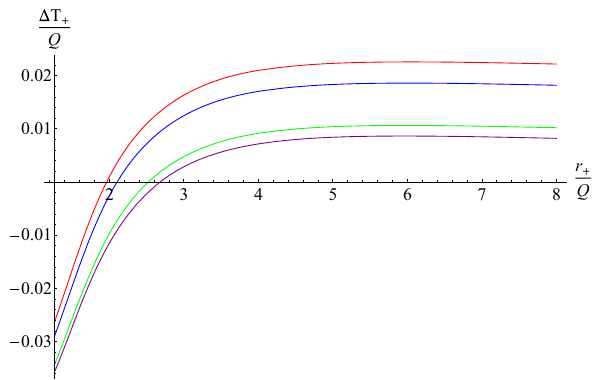
Fig. 6 We plot the difference of the temperature of the non-linear and usual charged dS black holes in terms of the reduced event horizon radius, under the different values of PQ 2 . The blue, red, green and purple curves correspond to PQ 2 = − 0 . 008, − 0 . 004, − 0 . 002, − 0 .